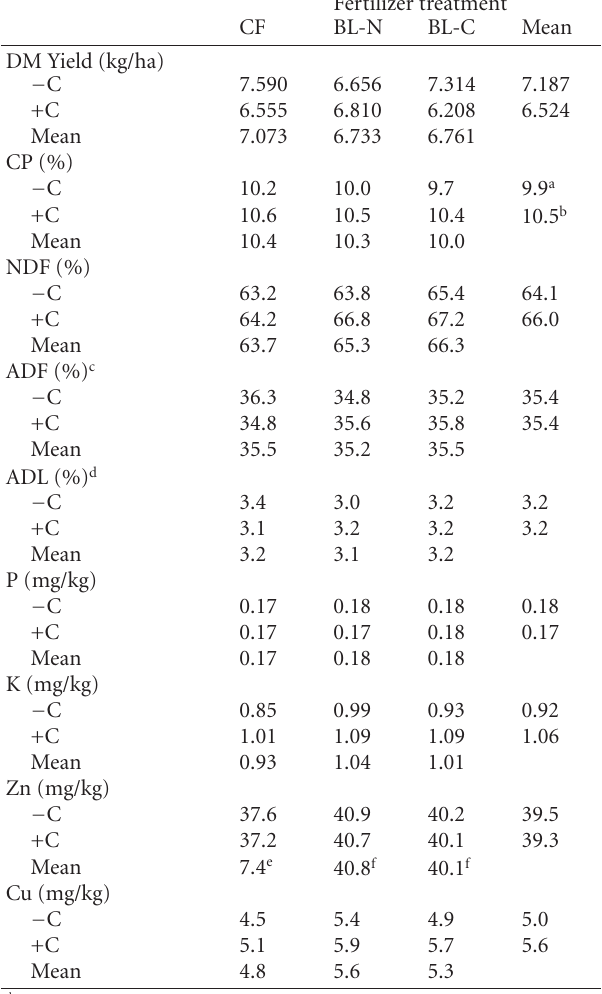
Table 2: Yield of dry matter (DM) and foliar concentrations (DM basis) of crude protein (CP), neutral detergent fiber (NDF), acid detergent fiber (ADF), acid detergent lignin (ADL), and select minerals from Johnsongrass interseeded with (+C) or without ( − C) white clover and amended with commercial fertilizer (CF), noncompacted broiler litter (BL-N), or compacted broiler litter